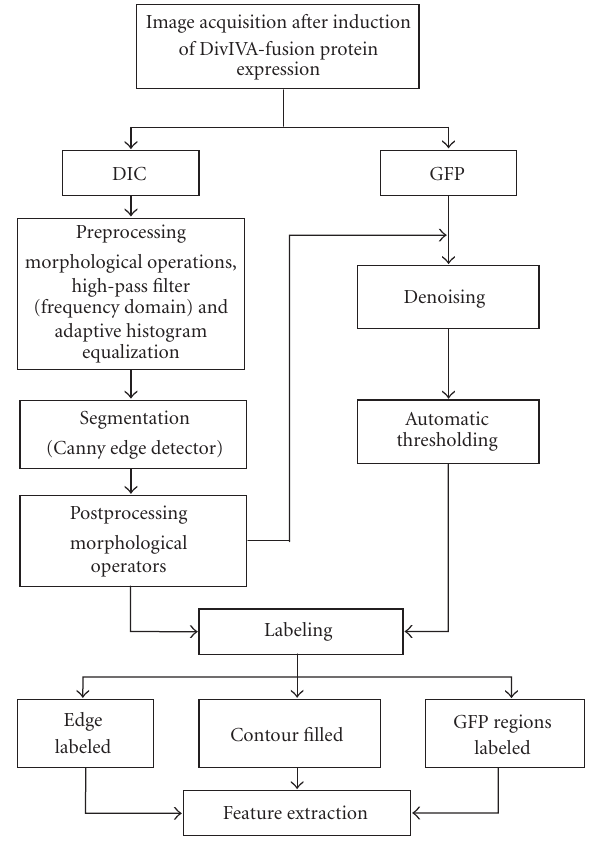
Figure 3: Image processing flow